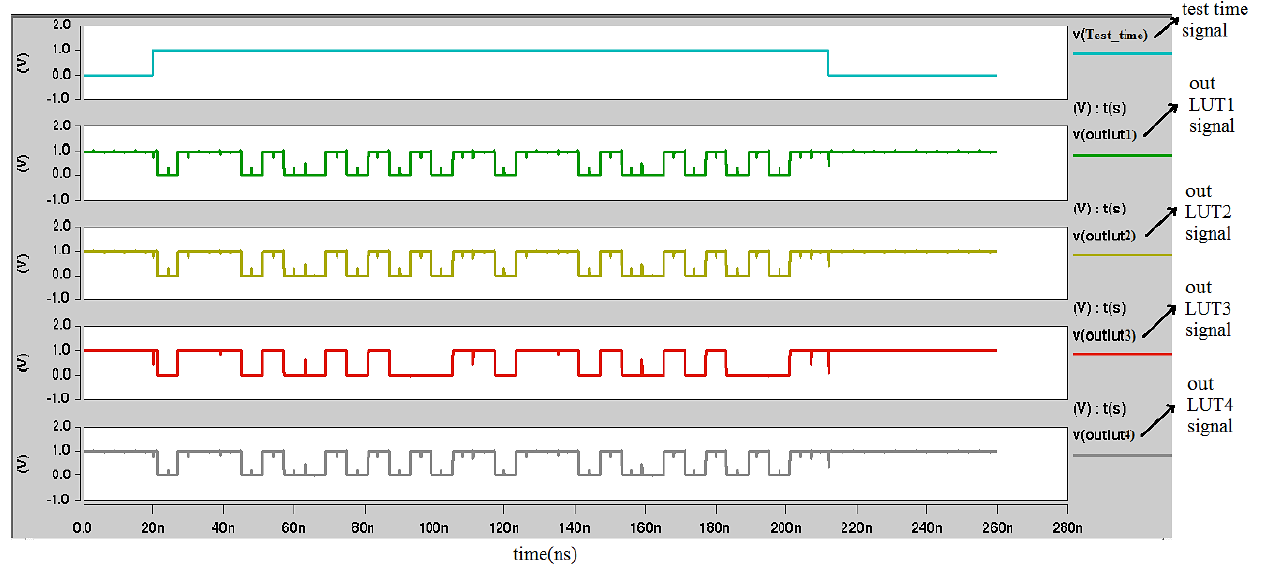
Figure12. Simulation results for single-cell fault in 3 rd